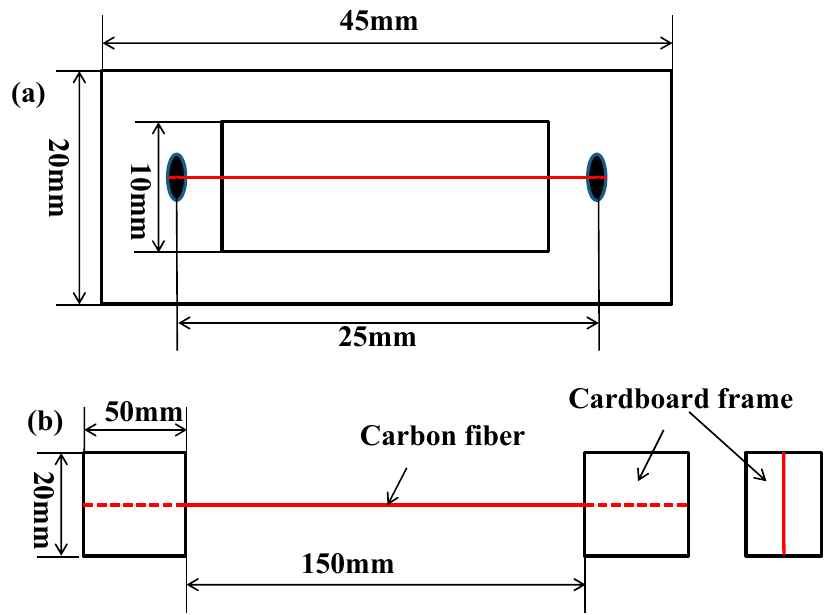
Figure 2. The schematic of ( a ) monofilament CF tensile specimen and ( b ) multifilament tensile specimen.